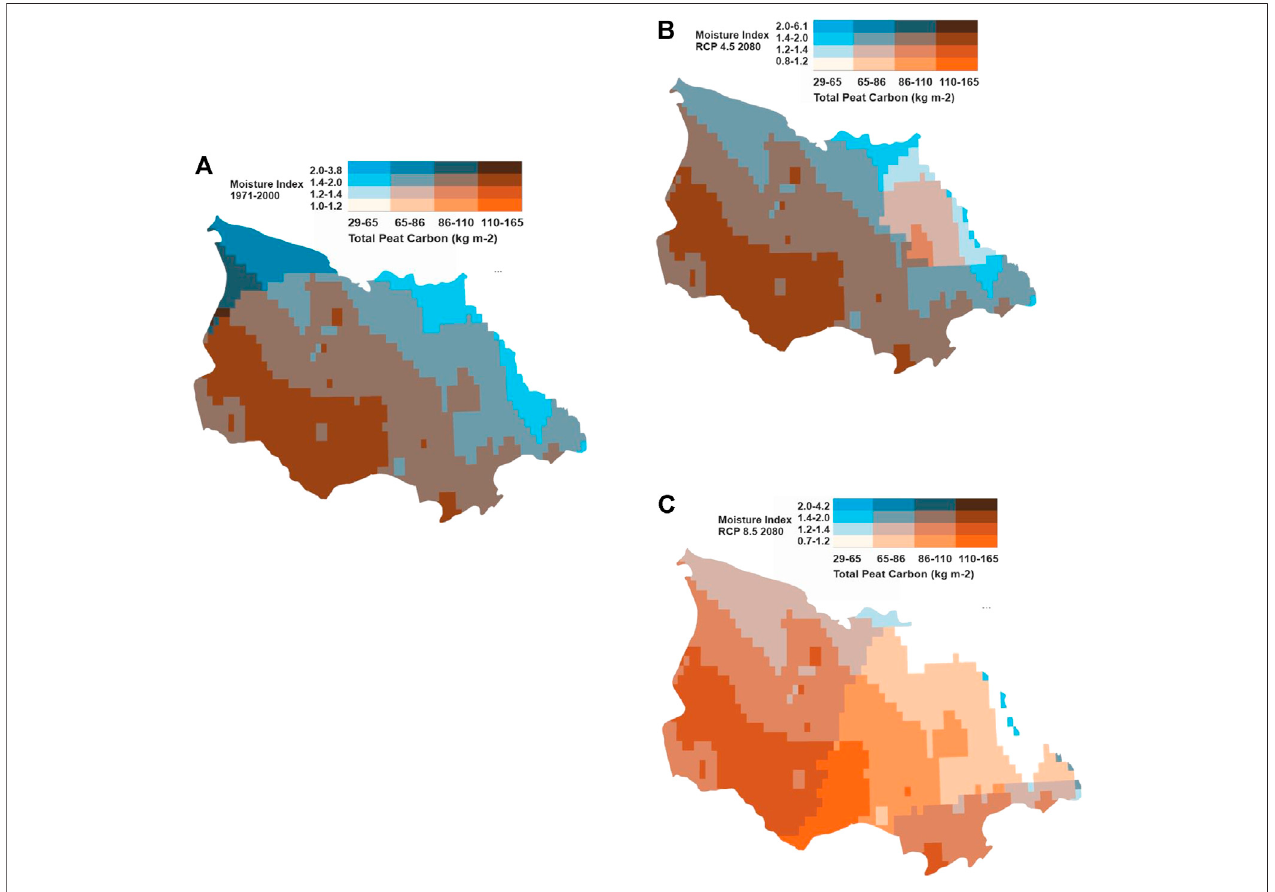
FIGURE 7 | Bivariate maps for the 74,300 km 2 study area and peat carbon mass baseline (A) , the 2080s for RCP4.5 (B) , and RCP8.5 (C) .